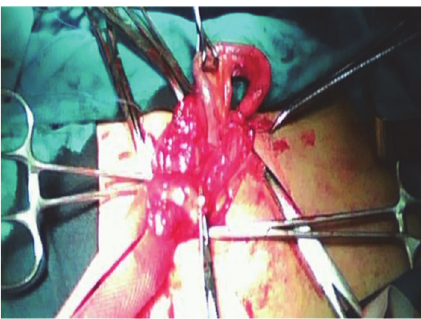
Figure 1: Intraoperative finding of an Amyand’s hernia.